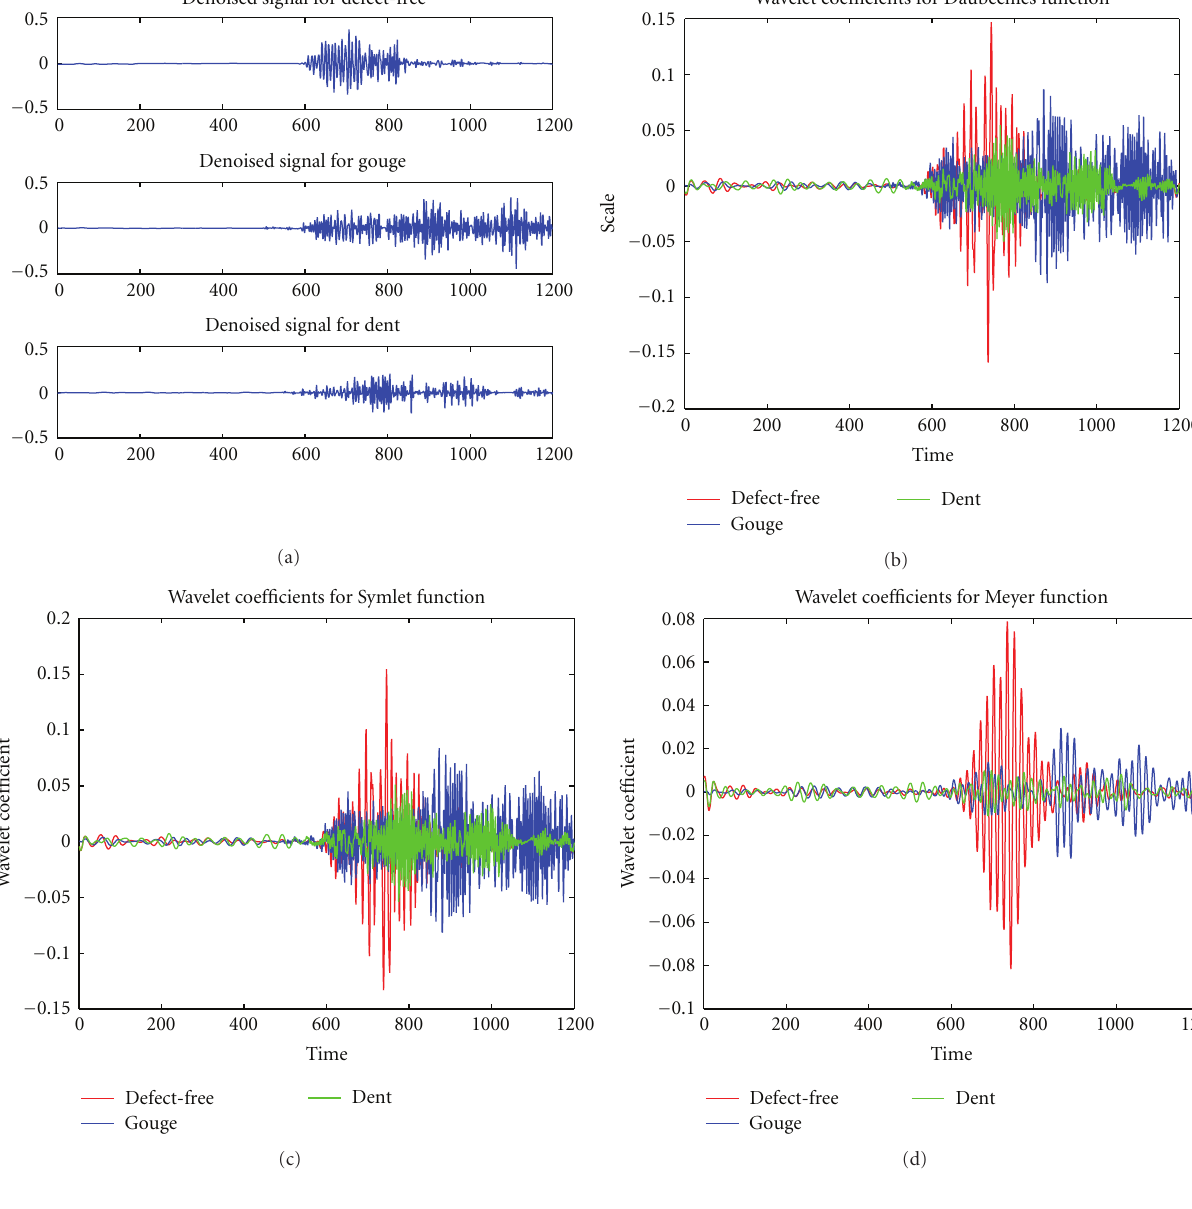
Figure 9: (a) denoised signals for defect-free, gouged, and dent pipes. Continuous wavelet transforms for defect-free, gouged and dented pipes when water flows through the pipes, (b) for Daubechies (db4) function, (c) for Symlet (sym4) function, and (d) for Meyer